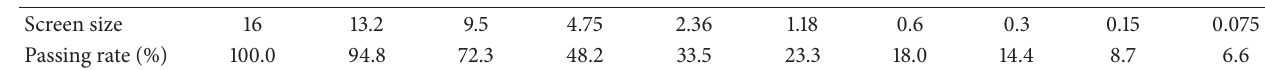
Table 2: Gradation composition of